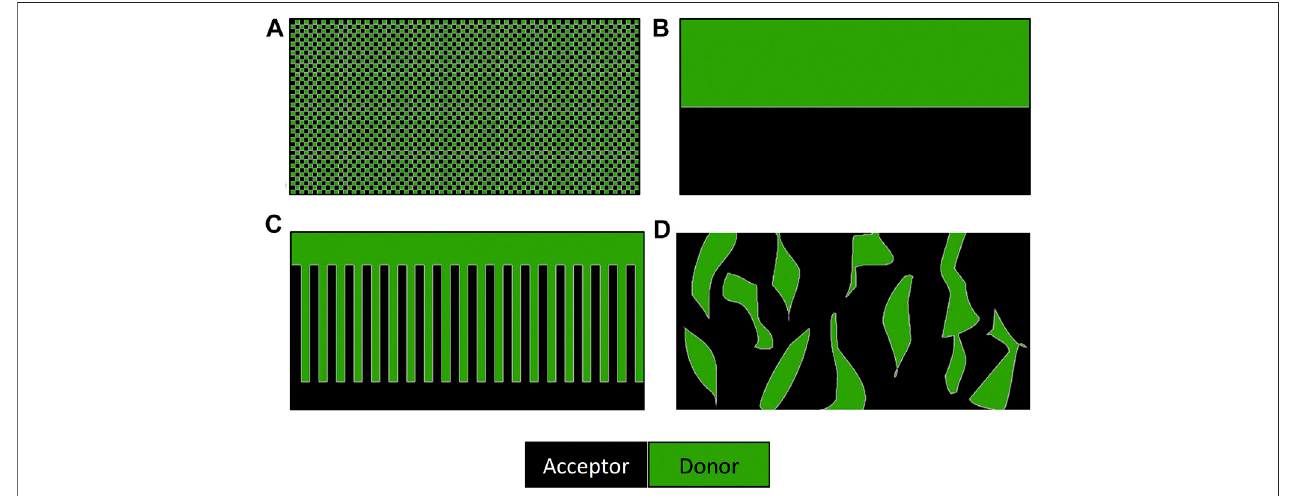
FIGURE 7 | Schematic representation of the cross-section of the nanomorphologies of bulk heterojunction solar cells. (A) Fine mixture of donor and acceptor molecules, (B) bilayer arrangement, (C) ideal morphology of a bulk heterojunction solar cells, and (D) typical morphology of a solution processes device (Scharber and Sariciftci, 2013).